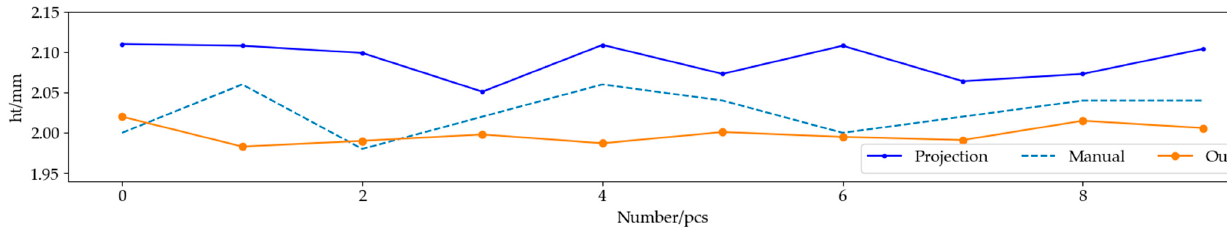
Figure 15. Graph of hs measurement data. 5. Conclusions In this work, a 3D point cloud measurement system for synchronous belts is built using a line-structured light sensor. Firstly, the contour point clouds of the synchronous belt are collected. To improve the accuracy and efficiency of measurement, the raw point clouds are filtered, and the number of the point cloud is reduced. Then, referring to the measurement plan of the synchronous belt, the point clouds are divided into plane and arc areas. In the plane areas, it can effectively reduce the fitting error by using the RAN- SAC algorithm. To obtain the effective area of the arc, a segmentation method based on a normal vector is proposed, which can effectively segment the target area. Subsequently, a curve fitting model suitable for the arc tooth profile is established by the least squares method. Finally, the parameters of each tooth are calculated. The experimental results show that the method in this paper can accurately and quickly detect the tooth profile parameters of the synchronous belt. The average errors of this method in parameters are less than 0.03 mm. This method provides a useful solution with a much smaller degree of error in the stability of the tooth profile. It is an obvious advantage over the classic, com- mon methods. Therefore, the detection scheme has great application prospects and pro- motion value. The main work in this paper focuses on point cloud noise reduction, point cloud simplification, point cloud segmentation, and size measurement. However, the in- spection of surface defects on the synchronous belt has not been thoroughly studied. Therefore, further research can be carried out on surface defects.